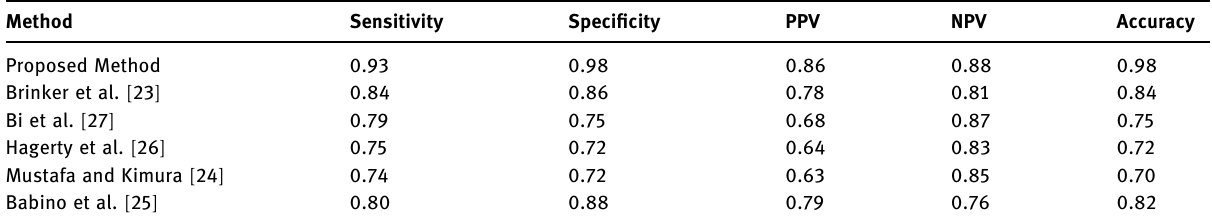
Table 4: The comparison results of the simulation